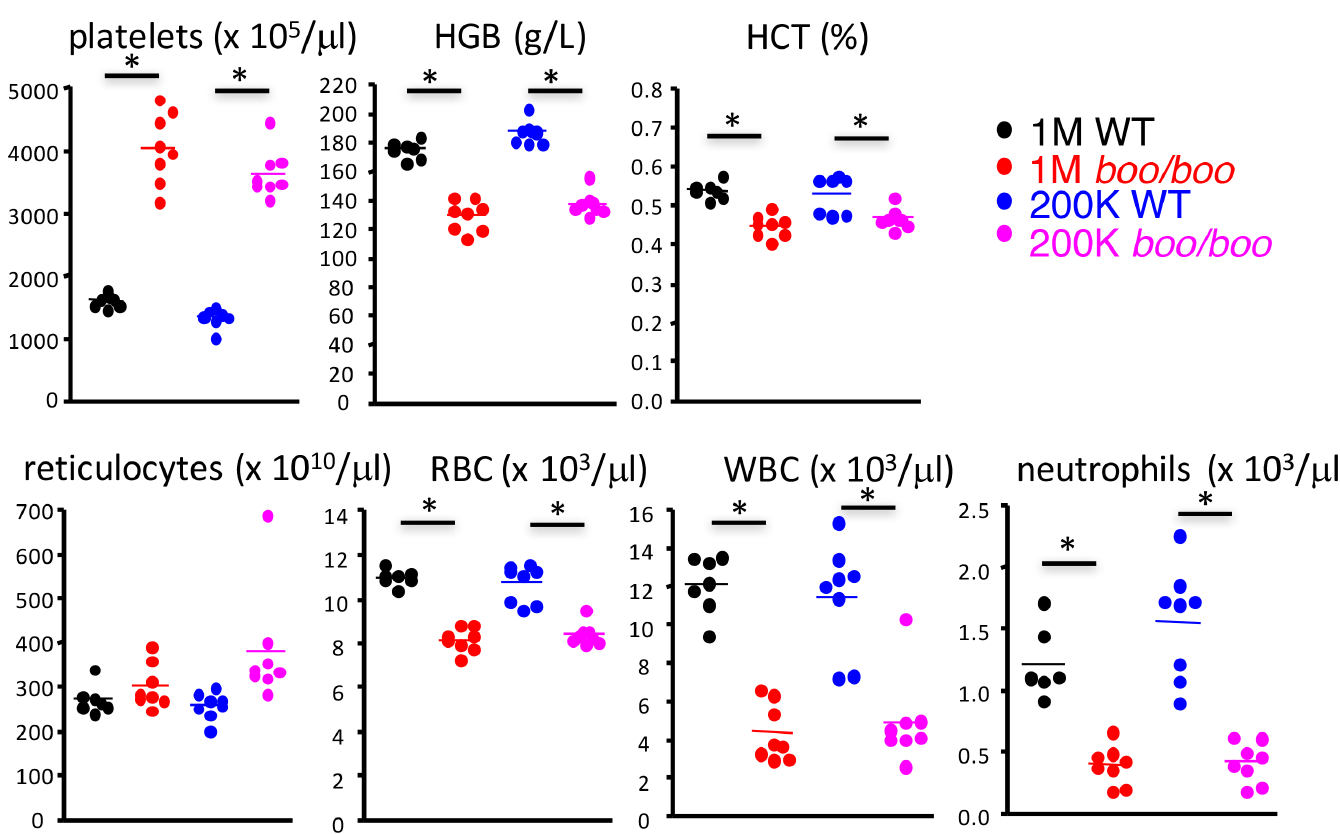
Fig 2. Peripheral blood analysis of chimerasreconstituted with booreana fetal liver. Chimeraswere preparedas describedin Fig 1. At 16-weekspost- transplant, blood composition was analyzed.Individualdata points are shown for boo/boo and WT chimeras, with the mean value indicatedby a horizontal bar. All comparisons betweenequivalent boo/boo and wild type chimeras were significantly different (p (cid:20) 0.05), except for reticulocyte counts in chimeras reconstituted with 1 x 10 6 cells. HGB = hemoglobin,HCT = hematocrit, RBC = red blood cells, WBC = white blood cells. Significantly different data sets are shownby *